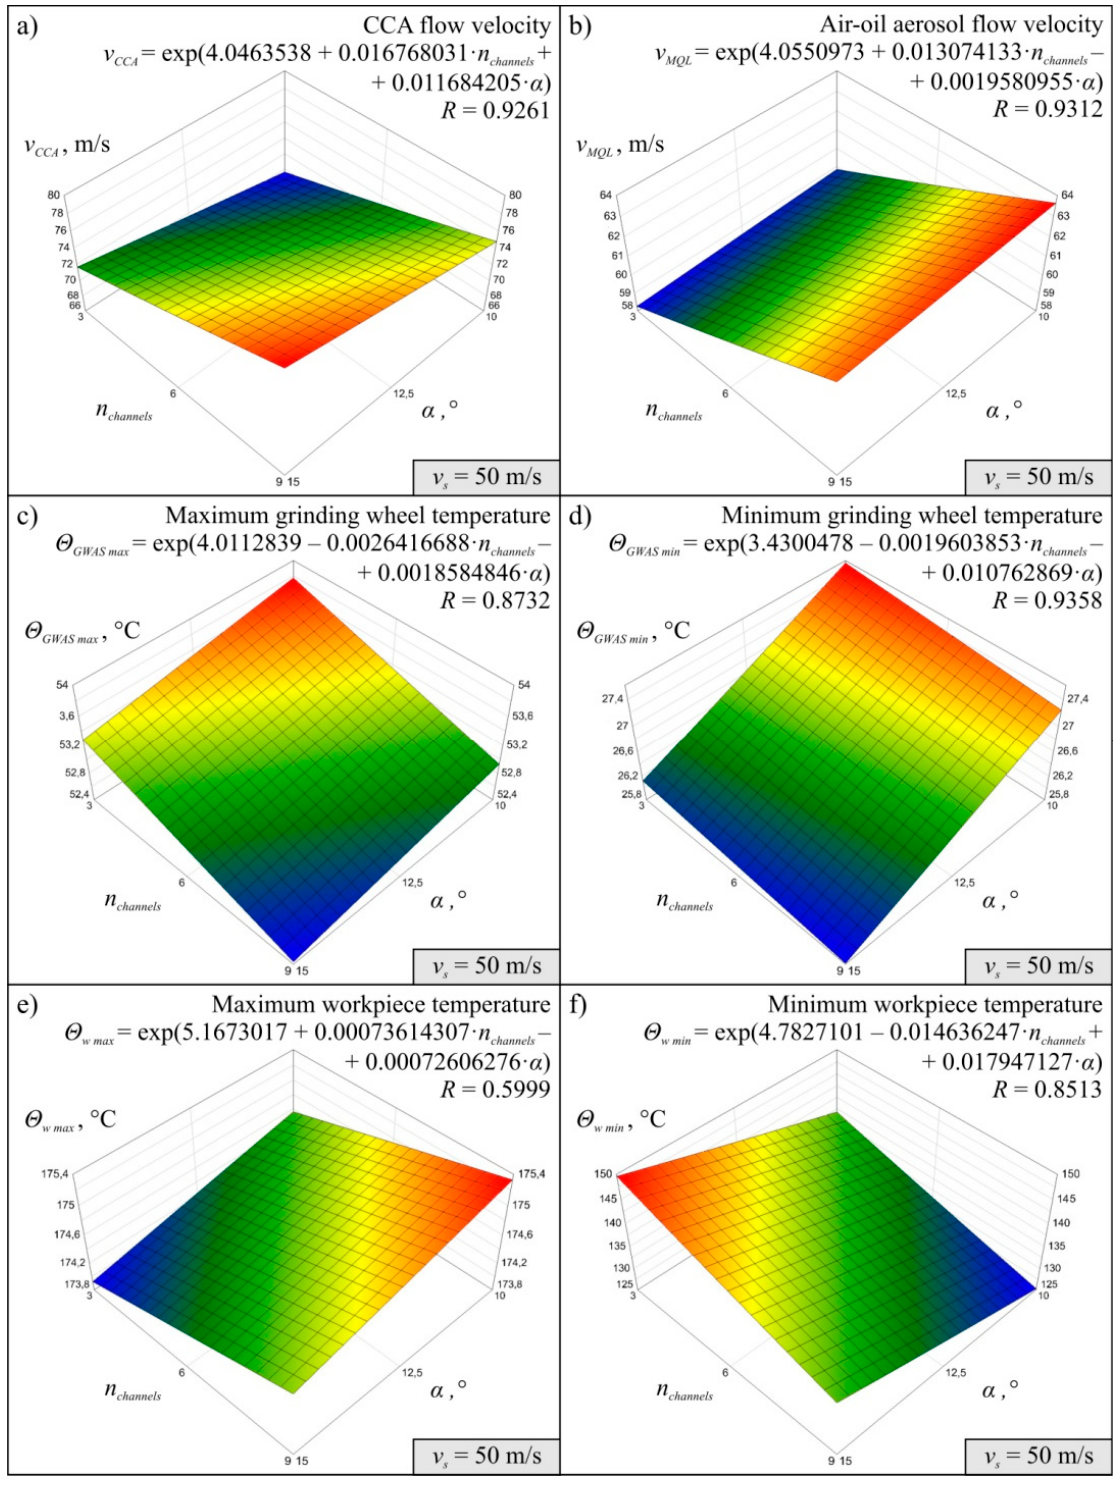
Figure 5. Mathematical models determined on the basis of simulation results for v s = 50 m/s: ( a ) v CCA ; ( b ) v MQL ; ( c ) Θ GWAS max ; ( d ) Θ GWAS min ; ( e ) Θ w max , ( f ) Θ w min.